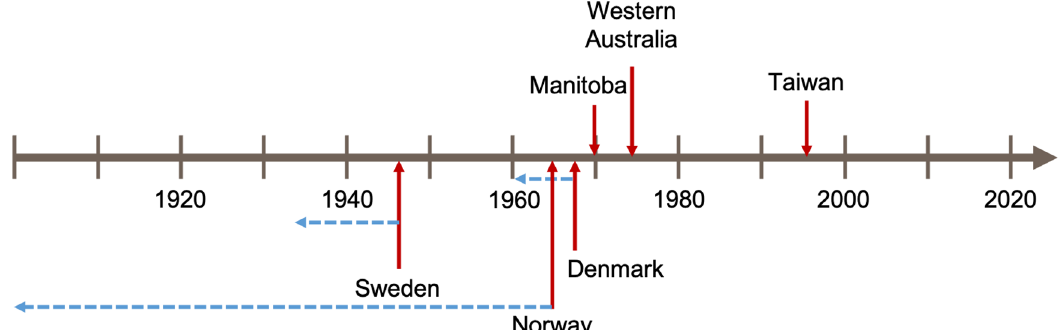
Figure 1: Temporal coverage of linked electronic health data for population-based multigenerational health research at six sites a , b